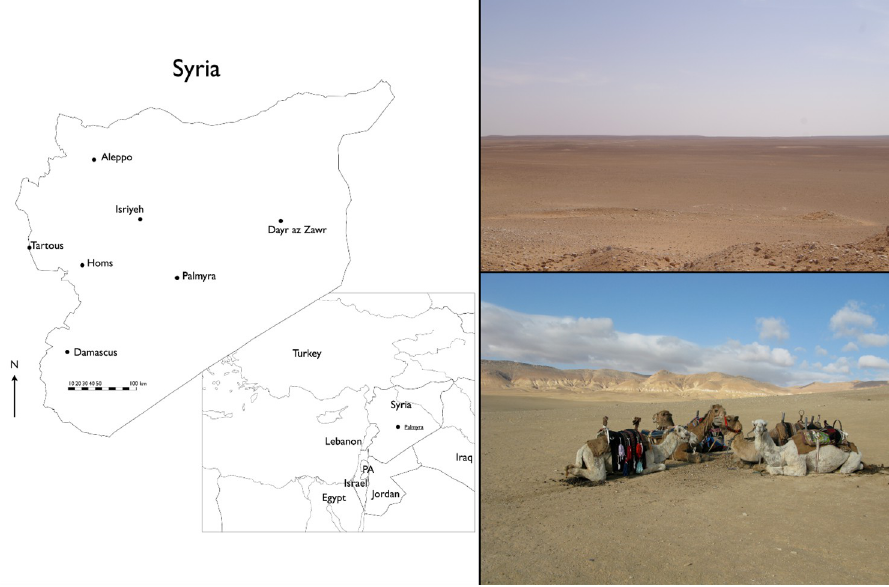
Fig 1. Palmyra’s surroundings. Clockwise starting from the left: Position of Palmyra (Eivind Heldaas Seland), gravel- plains southeast of Palmyra (reproduced with permission from J ø rgen Christian Meyer, original copyright 2006), limestone mountains north of Palmyra (Eivind Heldaas